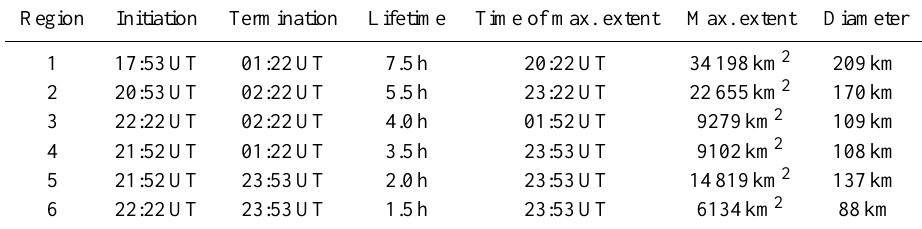
Table 1. Convective Regions’ temporal and spatial parameters, 30 September–1 October 2005.